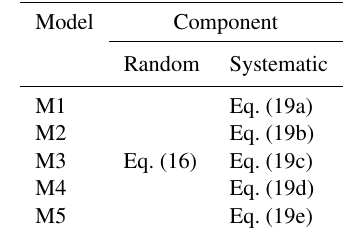
Table 5. Statistical models examined for each database.